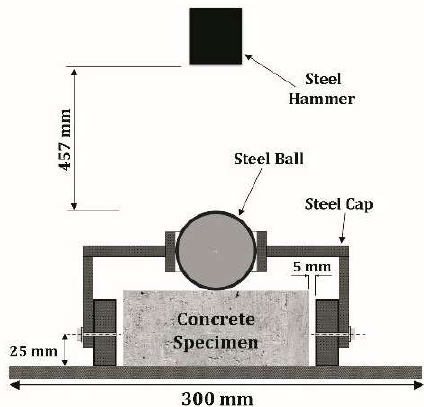
Figure 6. Schematic diagram of impact test—specimen setup.